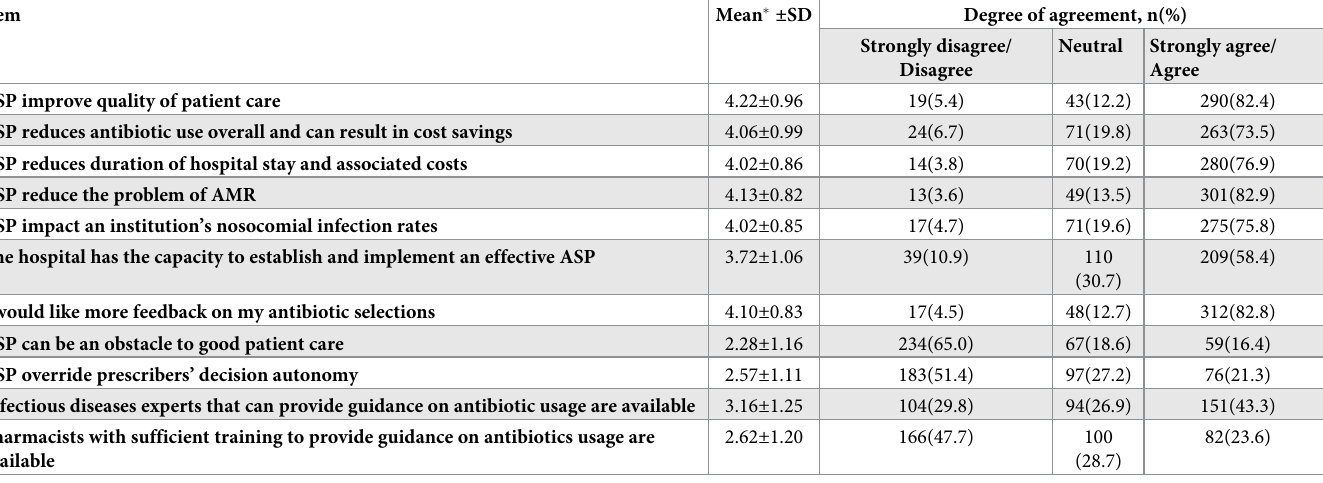
Table 4. Perceptions of physicians’ and pharmacists towards implementation of an antimicrobial stewardship program (ASP) at Tikur Anbessa Hospital (TASH), Addis Ababa, Ethiopia.